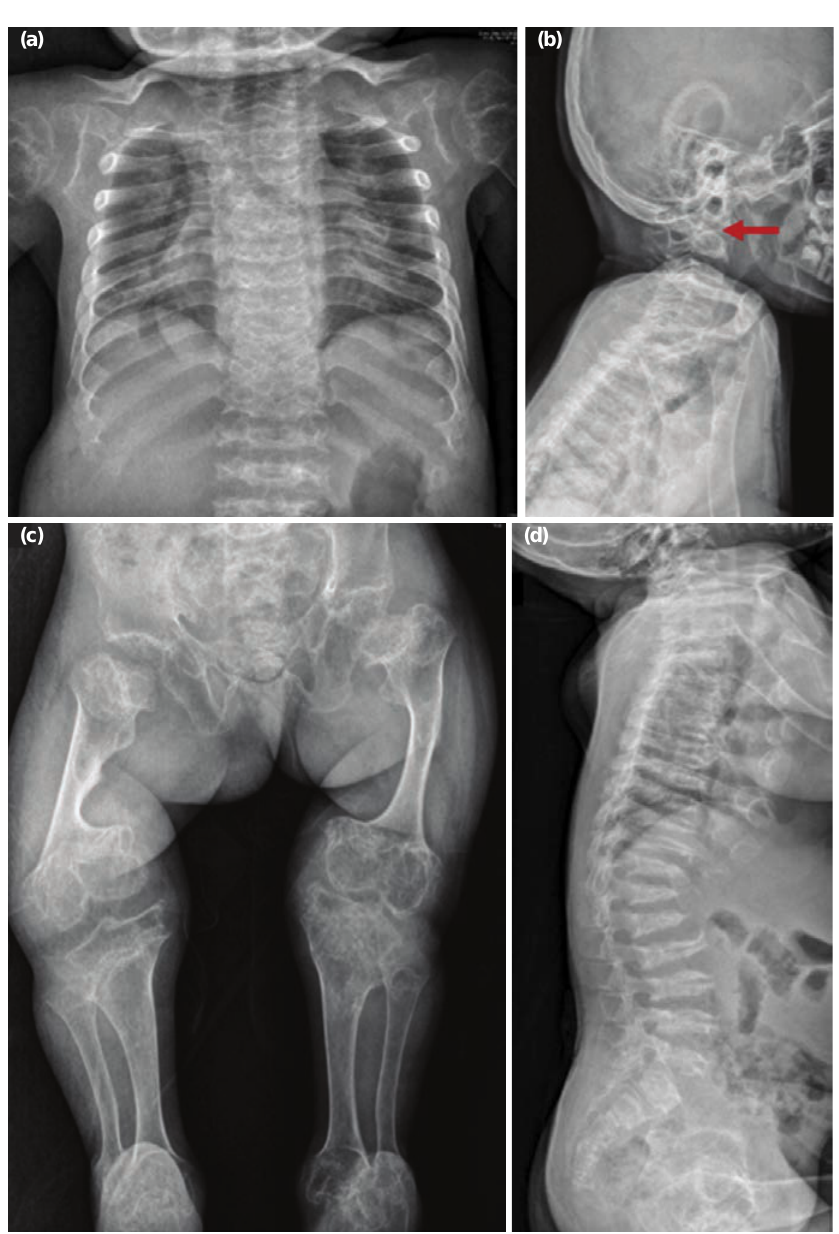
(a) Chest Radiograph shows narrow thorax with broad oar shaped ribs. (b) Lateral cervical spine shows severe odontoid Fig. 2: hypoplasia. (c) Halberd Pelvis with short wide ilia, narrow sciatic notches, dysplastic acetabuli, coxa vara and breva, short and thick diaphysis with dumbbell shaped ends, prematurely fused physis, flexion deformity at the knees, fibulae are shorter than tibiae. (d) Lateral spine radiograph shows thoracic lumbar kyphosis, platyspondyly with anterior wedging and characteristic axial split of the lumbar vertebrae